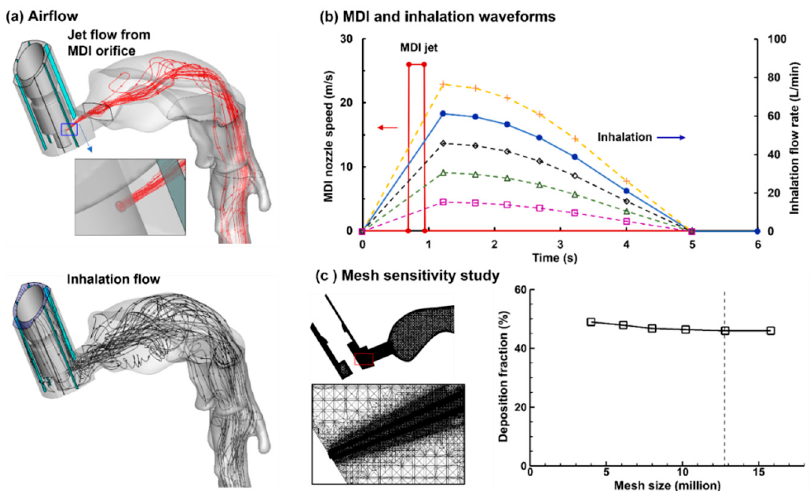
Figure 2. Airflow and computational mesh: ( a ) there are two airflows during MDI delivery: an excipient flow from the MDI orifice (upper) and an inhalation flow by the patient, ( b ) five inhalation waveforms with the peak inhalation rate ranging from 15 to 75 L/min, and ( c ) computational mesh and grid-independent study.